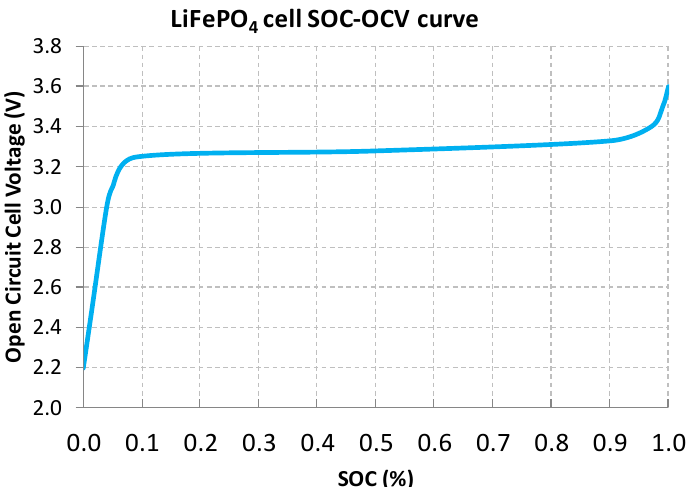
Figure 4. The course of voltage changes of a single LiFePO4 cell, depending on the State of Charge (SOC).